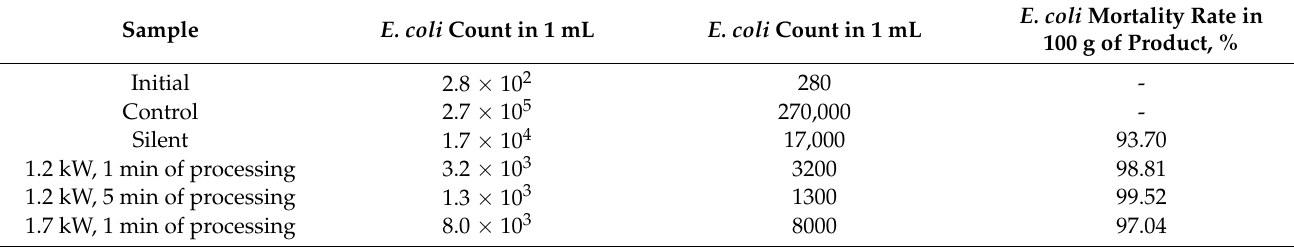
Table 1. Colon bacterium mortality rate according to processing conditions.